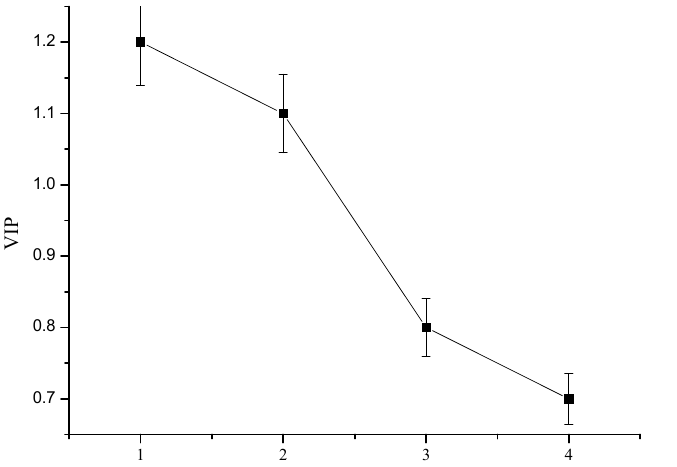
Figure 7. Ranking of variable importance in projection (VIP) values of land-use indexes affecting water quality. Note: 1 — Proportion of green space (%); 2 — EIA (%); 3 — IIA ratio (%); 4 — Proportion of impermeable underwater surface (%).